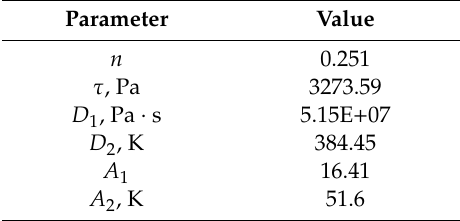
Table 5. Cross-WLF parameters of the considered polypropylene.